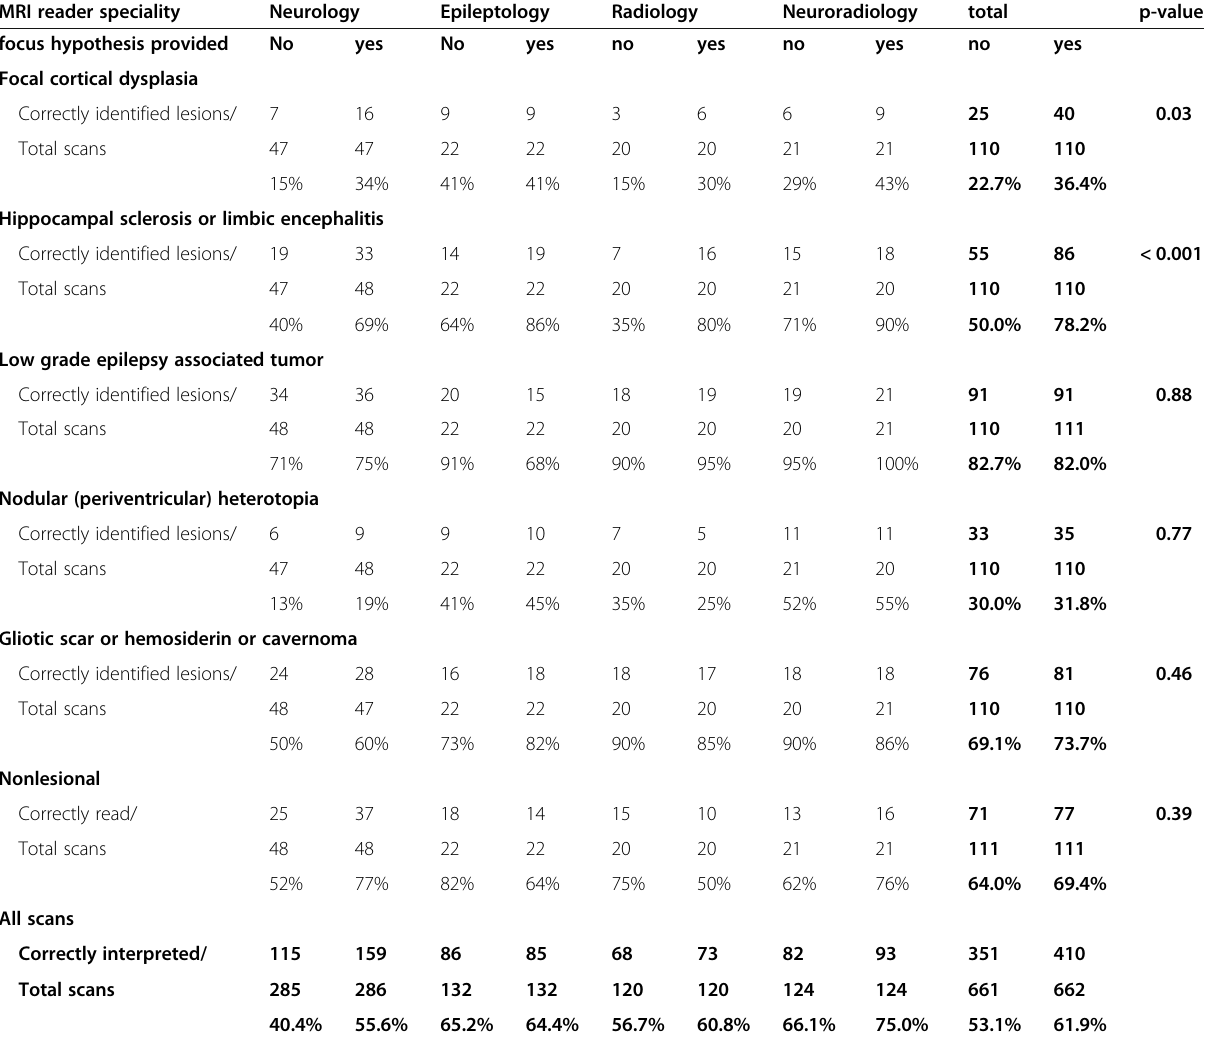
Table 2 No of correctly read MRIs stratified by lesion category, provision of focus hypothesis, and reader specialty. P -values refer to the difference of detecting the lesion constellation with or without focus hypothesis for all readers MRI reader